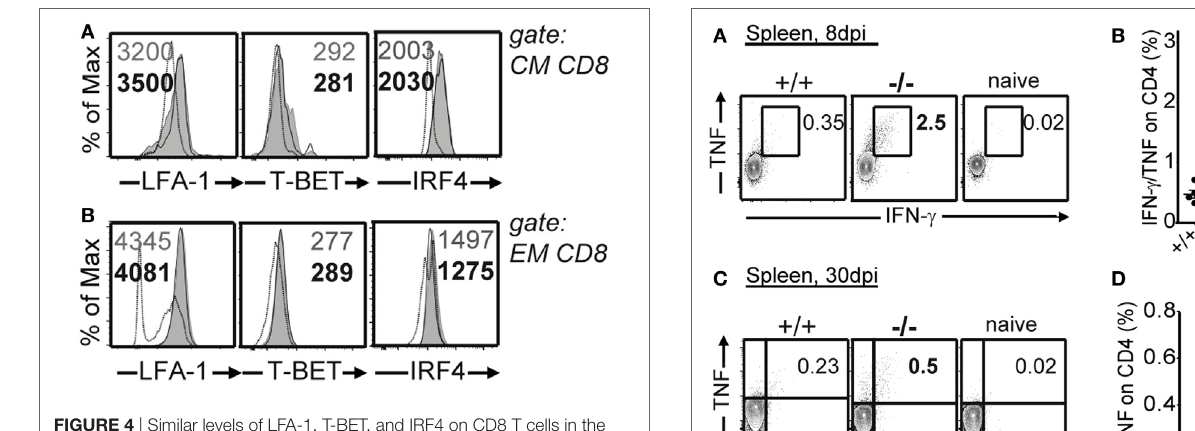
FigUre 4 | Similar levels of LFA-1, T-BET, and IRF4 on CD8 T cells in the absence of protein tyrosine phosphatase non-receptor 22 (PTPN22). PTPN22 + / + (black circles) and PTPN22 − / − (white circles) mice were infected as in Figure 1 . (a,B) LFA-1, T-BET, and IRF4 levels were determined in PTPN22 + / + and PTPN22 − / − central memory (CD44 + CD62L + ) (a) and effector memory (CD44 + CD62L − ) (B) polyclonal CD8 cells 8 days post infection (dpi). Representative histogram overlays show one mouse per group. Data are derived from a total of three independent experiments, one representative experiment is shown per